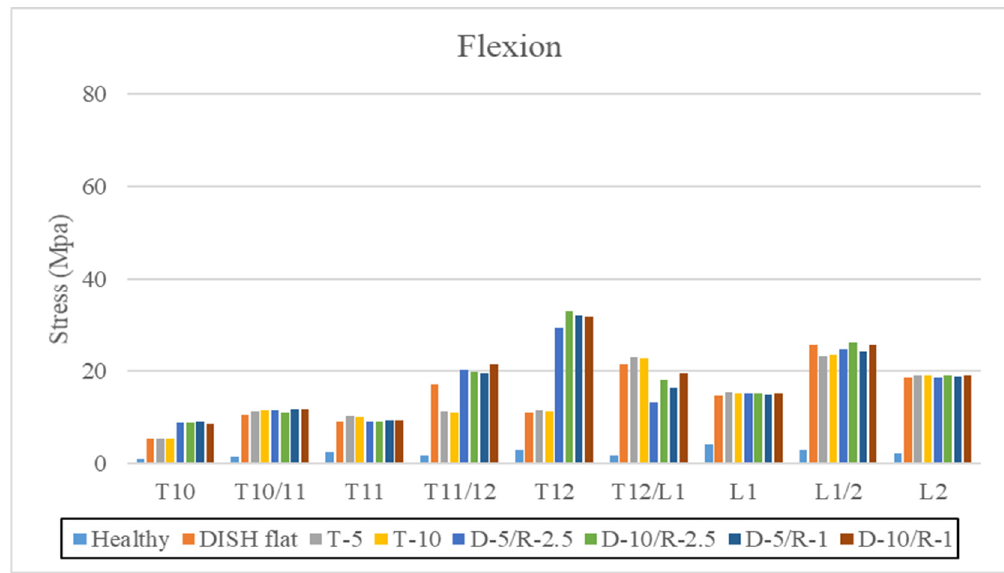
from T10 to L2 vertebrae are shown in flexion (Table 4 and Figure 10).